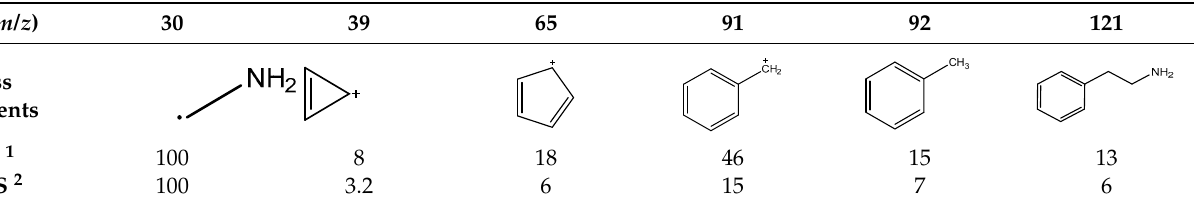
Table 1. Comparison of the experimental and database mass spectra for PEA.